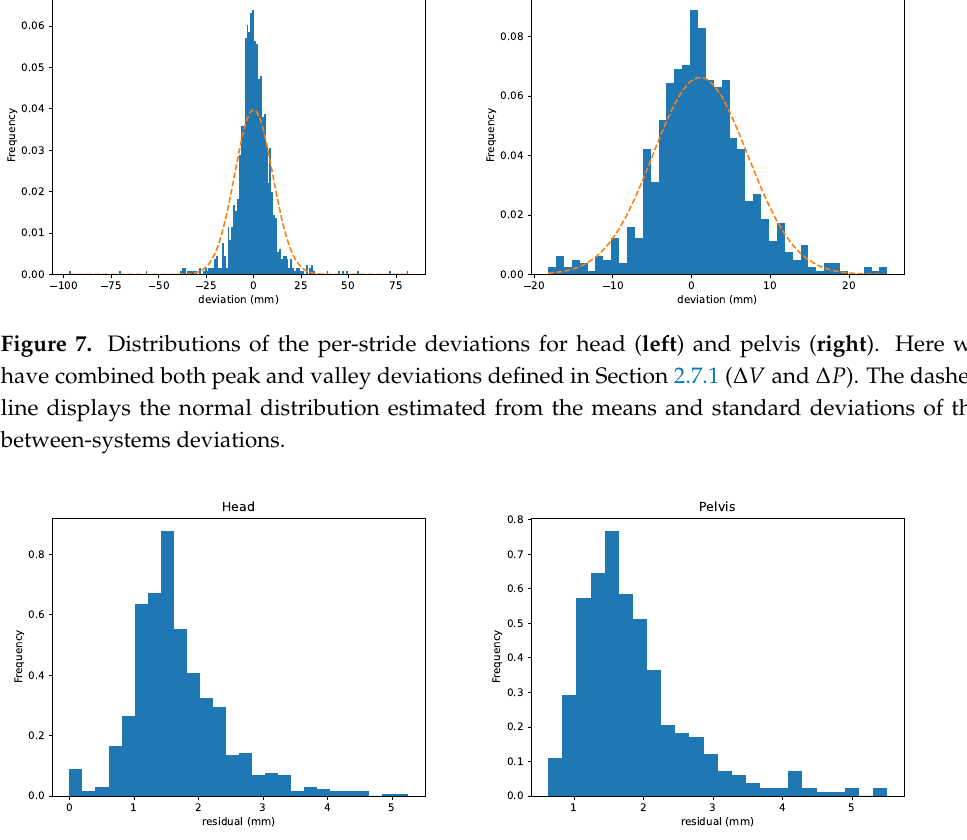
Figure 8. Distributions of the absolute values for stride mean residuals for head ( left ) and pelvis ( right ). Table 3. Results summary for the measurement deviations between the systems over the entire dataset. In the top 6 rows we provide combined per-trial deviations ( ¯ D ) using both deviations for the normalised MinDiff ( ∆ ¯ V ) and MaxDiff ( ∆ ¯ P ). For both head and pelvis, we compute the overall absolute mean, maximum and minimum deviations. In the bottom two rows we provide mean root mean square deviations (RMSD) as a comparison of the shape of the vertical displacement